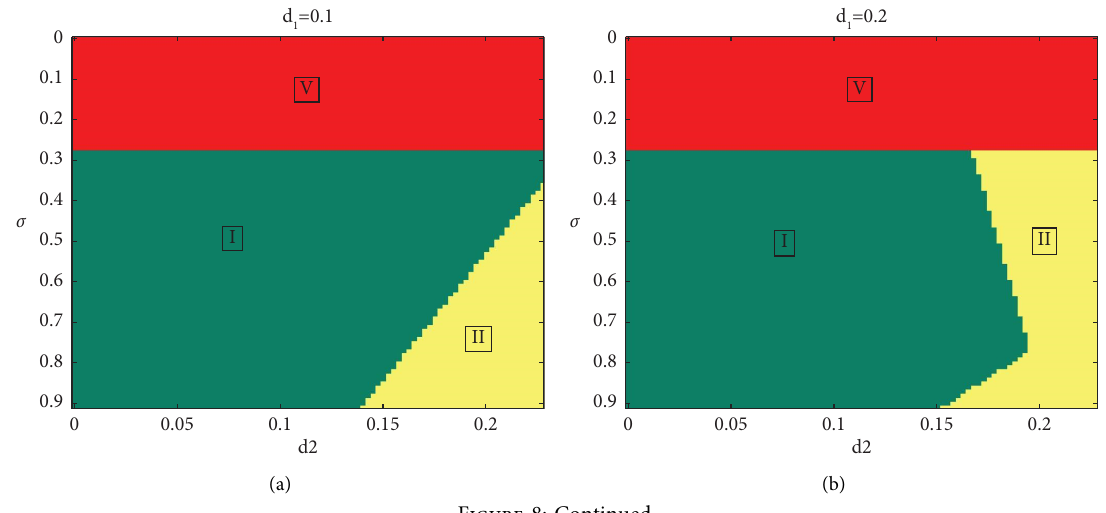
Figure 7: ( a ) , ( b ) , ( c ) , ( d ) are parameter planes of M with respect to d � 0 . 15 in (b), d � 0 . 22 in (c), d � 0 . 3 in (d). Te results show that M < 1 in region I and M > 1 in regions II and in (a), d 2 2 2